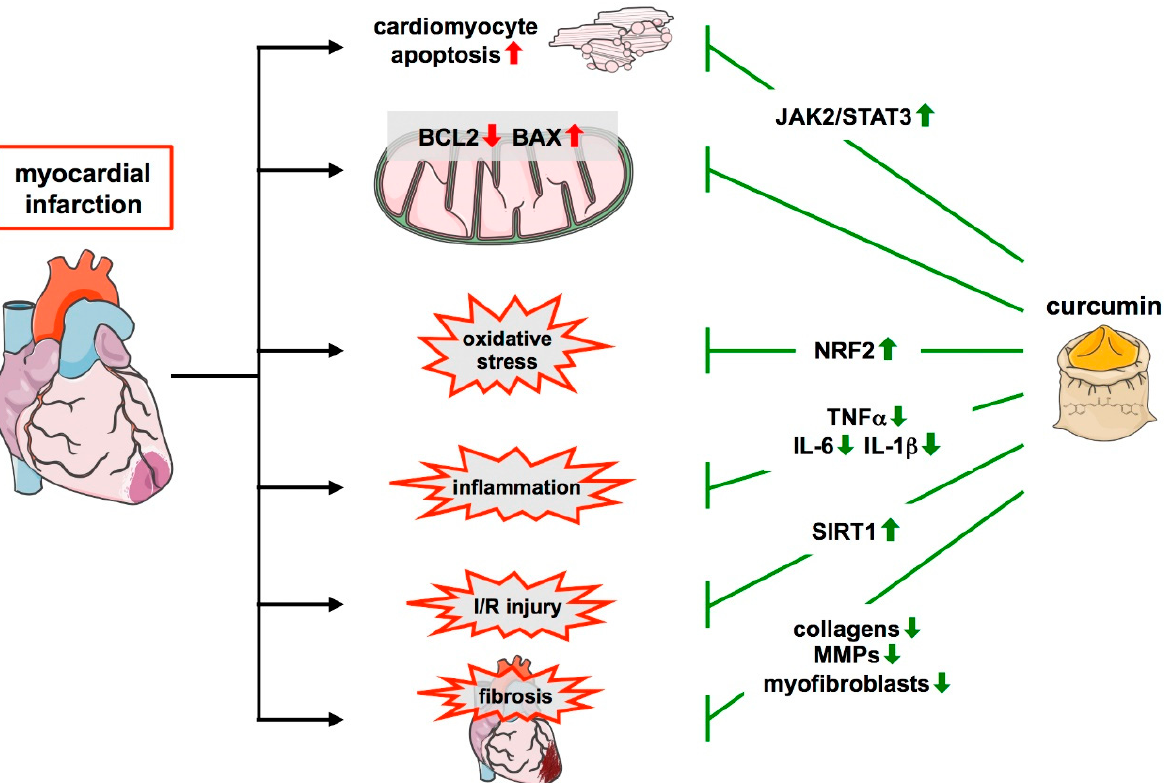
Figure 4 . Protective role of curcumin in myocardial infarction and remodeling. During myocardial infarction, multiple changes occur in the infarcted heart which is positively affected by curcumin. This nutraceutical protects cardiomyocytes by activating the JAK2/STAT pathway and attenuates